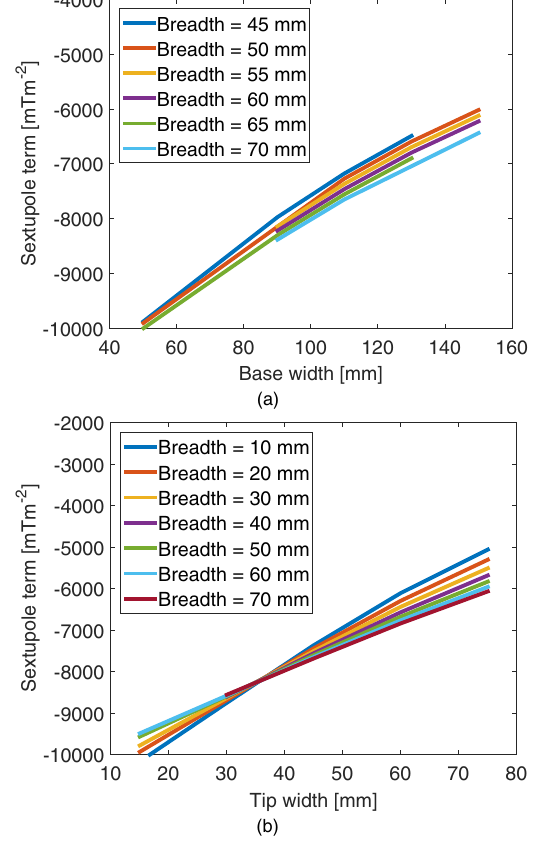
FIG. 13. Sextupole component vs rod width for the base ellipse (a) and tip ellipse (b).